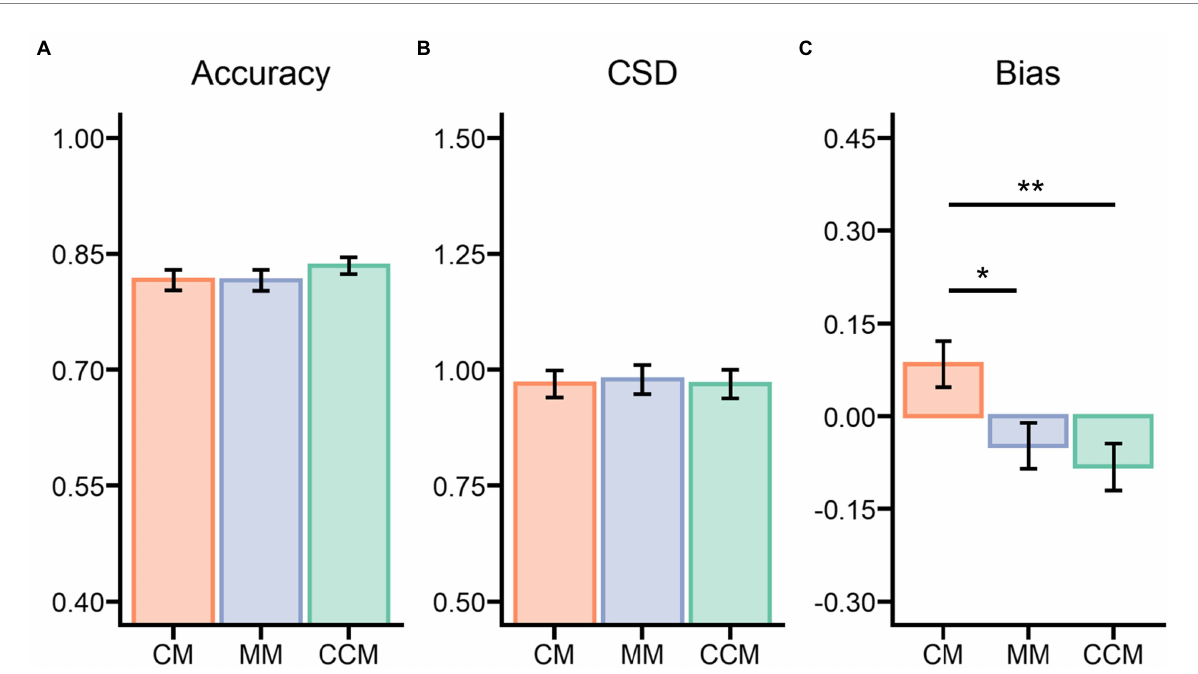
FIGURE 5 Results of Experiment 2 for the matching conditions on (A) VWM accuracy, (B) the ensemble circular standard deviation (CSD) of the mean identity estimations, and (C) the ensemble bias of the mean identity estimations. CM, clockwise matching condition; MM, mismatching condition; CCM, counterclockwise condition. * p < 0.05, ** p <